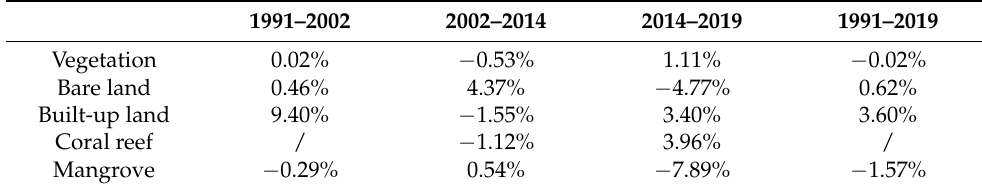
Table 4. Dynamic degree of land-use types in Fiji from 1991 to